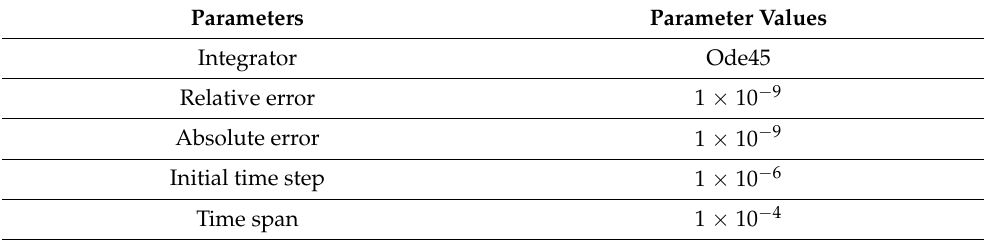
Figure 6. Contact model between socket and ball. Table 2. Integral parameters.